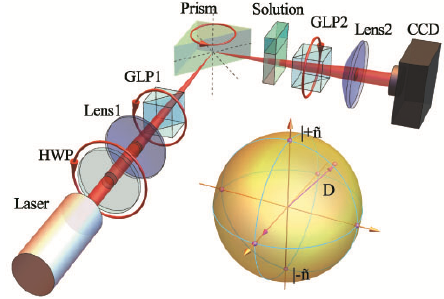
Fig. 2 Experimental setup for characterizing the spin Hall effect of light. He-Ne laser at 632.8 nm; prism with refractive index n =1.515; Lens1 and Lens2 with effective focal lengths of 50 mm and 250 mm, respectively; Glan laser polarizers (GLP), GLP1 and GLP2 as well as CCD (Coherent Laser Cam HR).